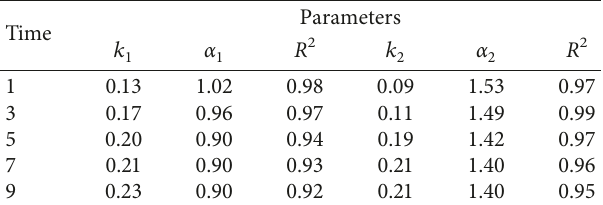
Figure 7: Attenuation of PGV with distance under different tamping times. (a) In radial direction. (b) In vertical direction. Table 2: Attenuation parameters of PGV under odd time